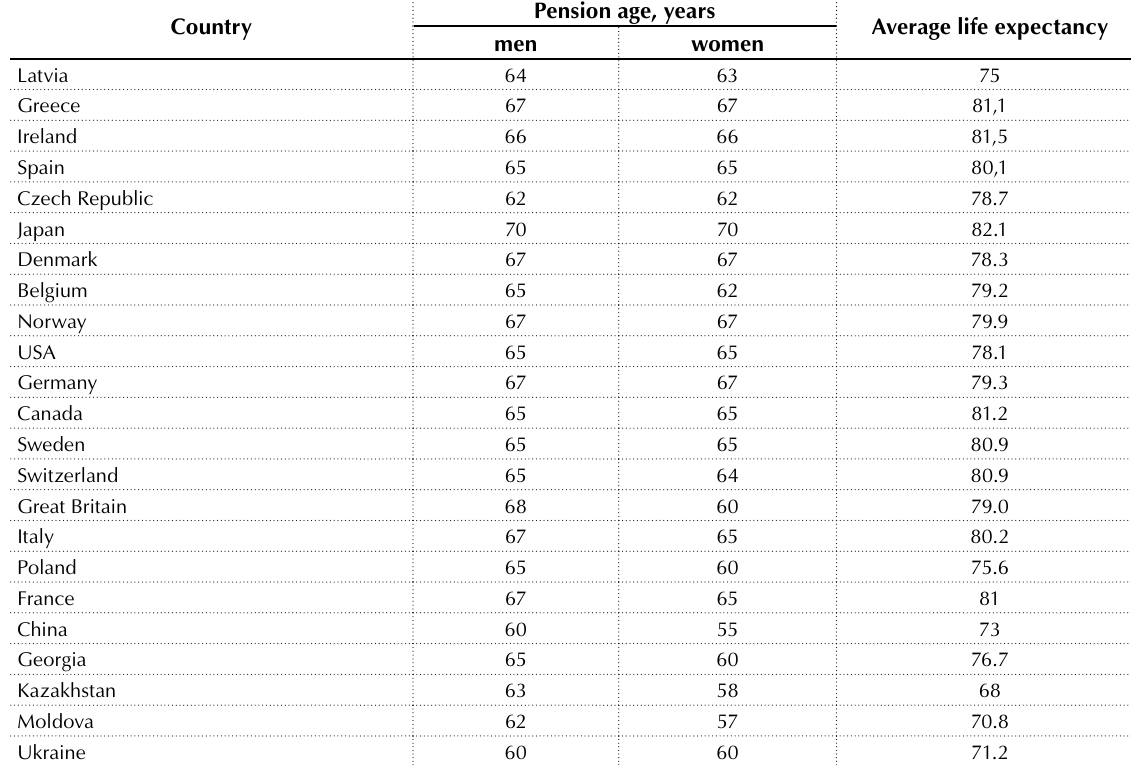
Table 2. Pension age in some